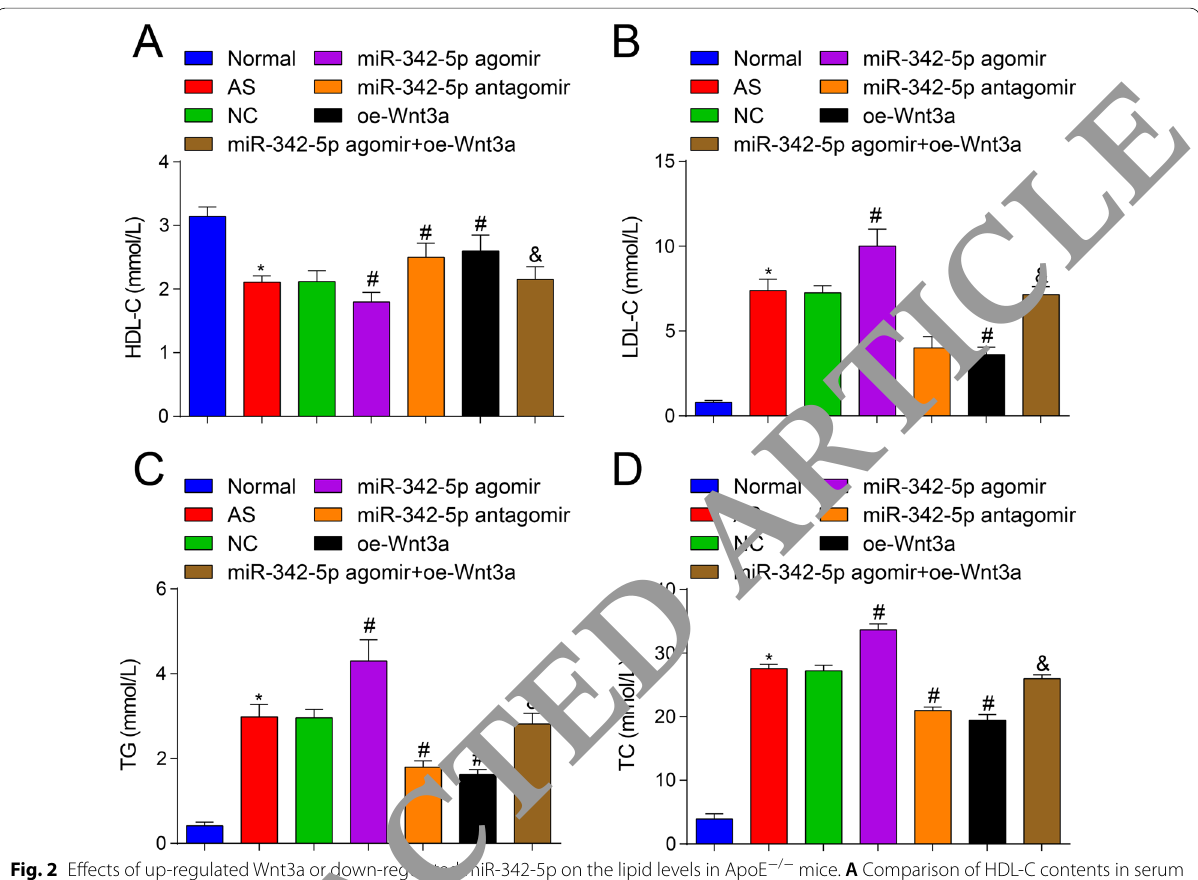
Fig. 2 Effects of up-regulated Wnt3a or down-regulated miR-342-5p on the lipid levels in ApoE − / − mice. A Comparison of HDL-C contents in serum of mice group. B Comparison of LDL-C contents in serum of mice group. C Comparison of TG contents in serum of mice group. D Comparison of TC contents in serum of mice group. n 12. * P < 0.05 vs. the normal group, # P < 0.05 vs. the NC group. & P < 0.05 vs. the miR-342-5p agomir group. = Measurement data were indicated as mean standard deviation. Comparisons among multiple groups were assessed by one-way ANOVA followed ± by Tukey’s multiple comparisons test. AS, atherosclerosis; NC, negative